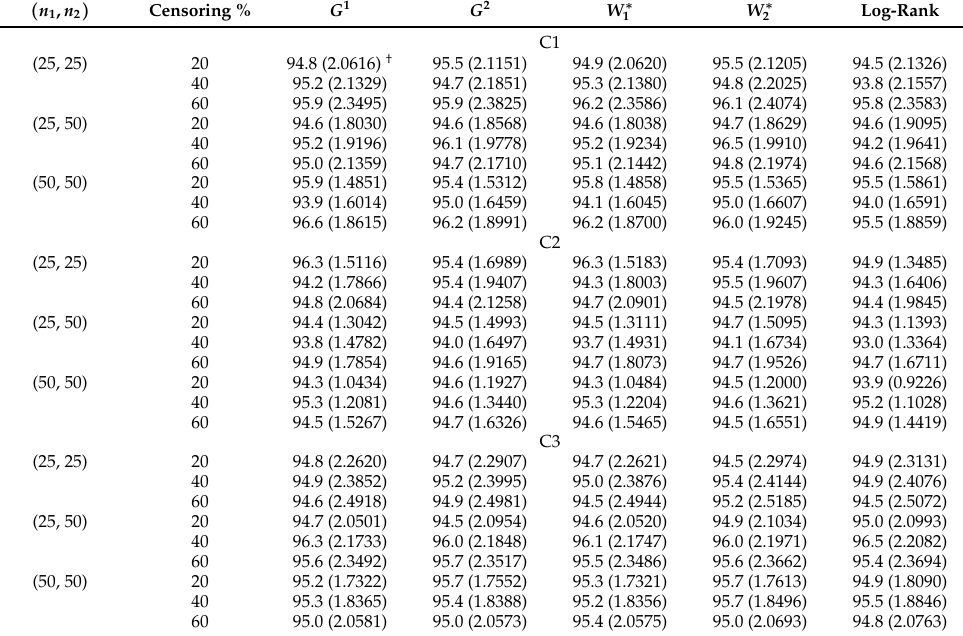
Table 1. Empirical coverage probability (ECP, %) and empirical mean length (EML) of confidence interval at α = 0.05, θ =